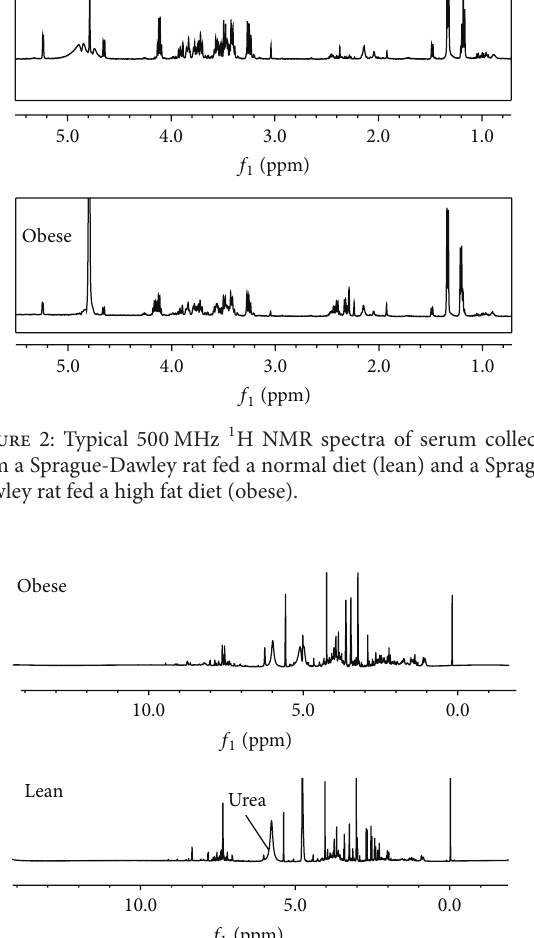
Table 2: 1 H NMR assignments of metabolites in rat’s serum and